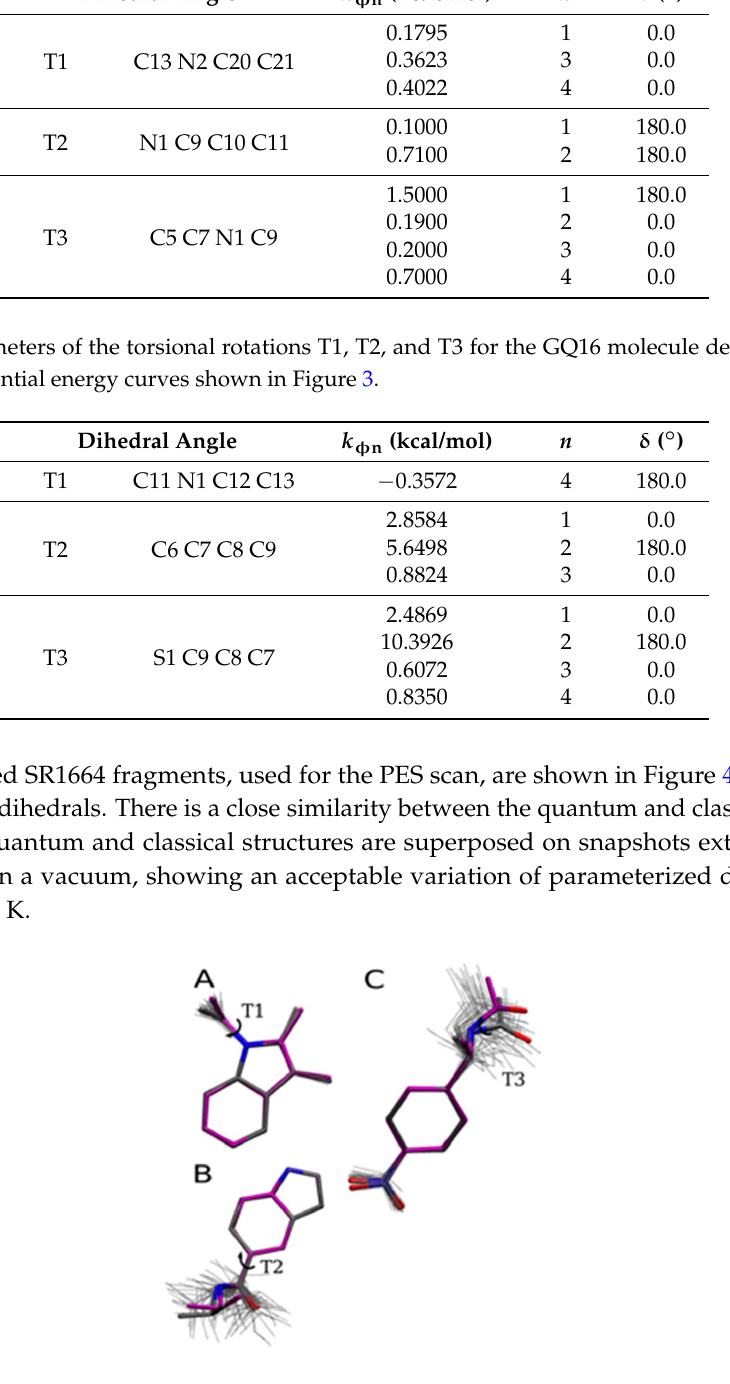
Table 1. Parameters of the torsional rotations T1, T2, and T3 for the SR1664 molecule determined by fitting the potential energy curves shown in Figure 2.